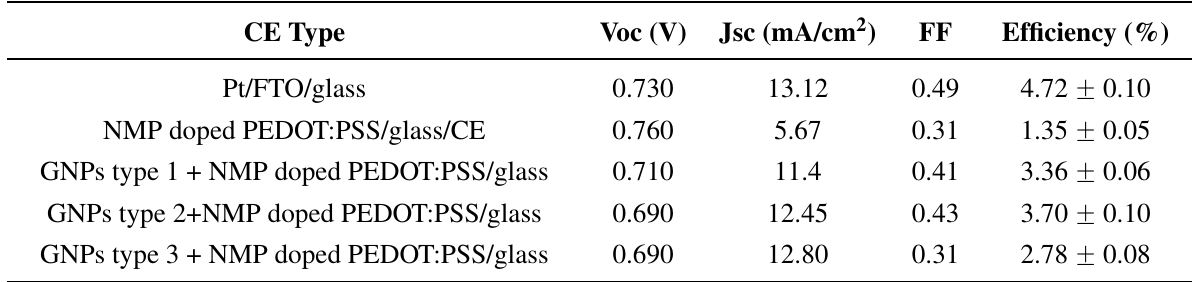
Table 2. The photovoltaic parameters of the Pt and FTO free CEs-DSSCs with various types of GNPs plus PEDOT:PSS composite films (measured at 100 mW/cm 2 ; cell active area was 0.8 cm 2 ).